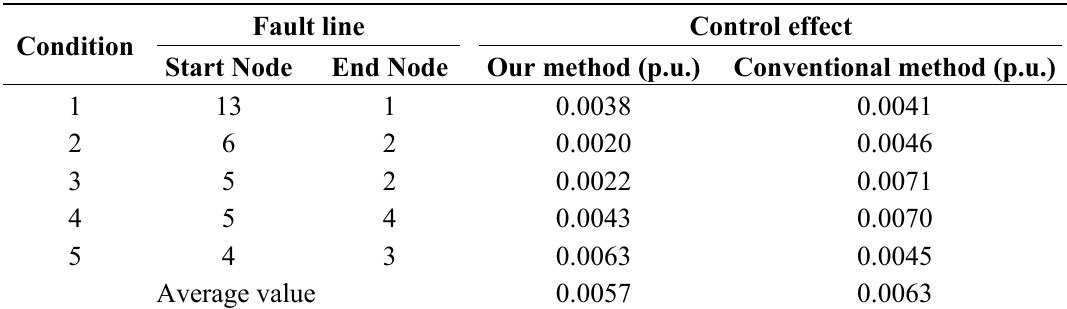
Table 2. Control effect of each fault